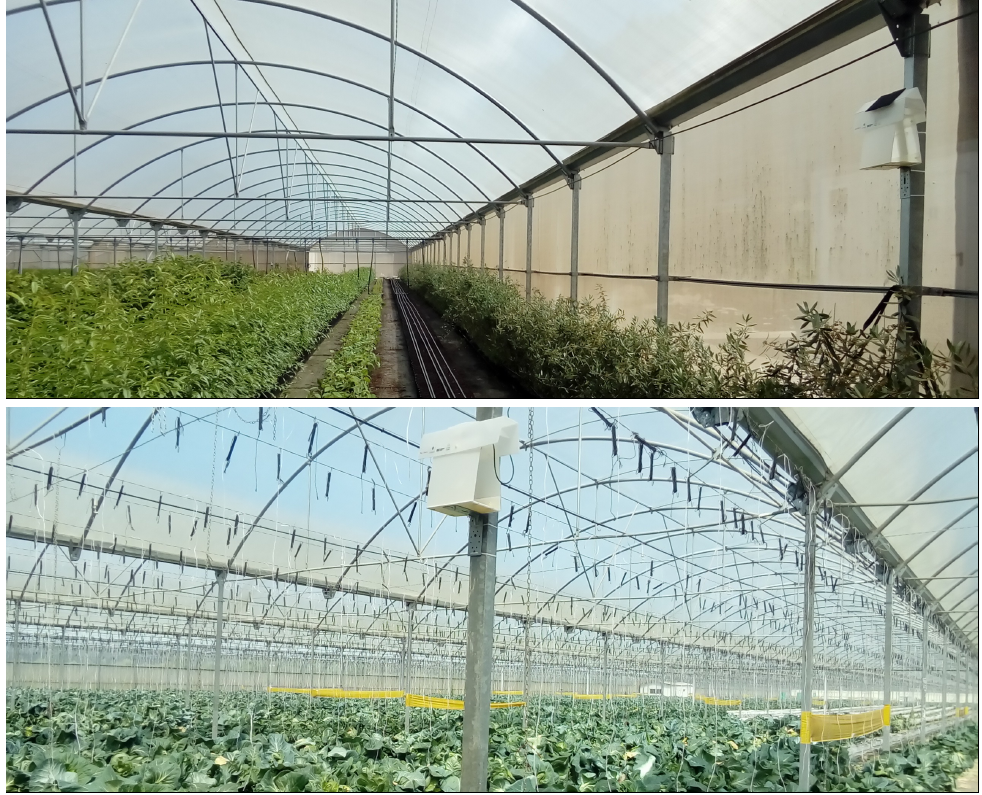
Figure 9. Trap structures at the